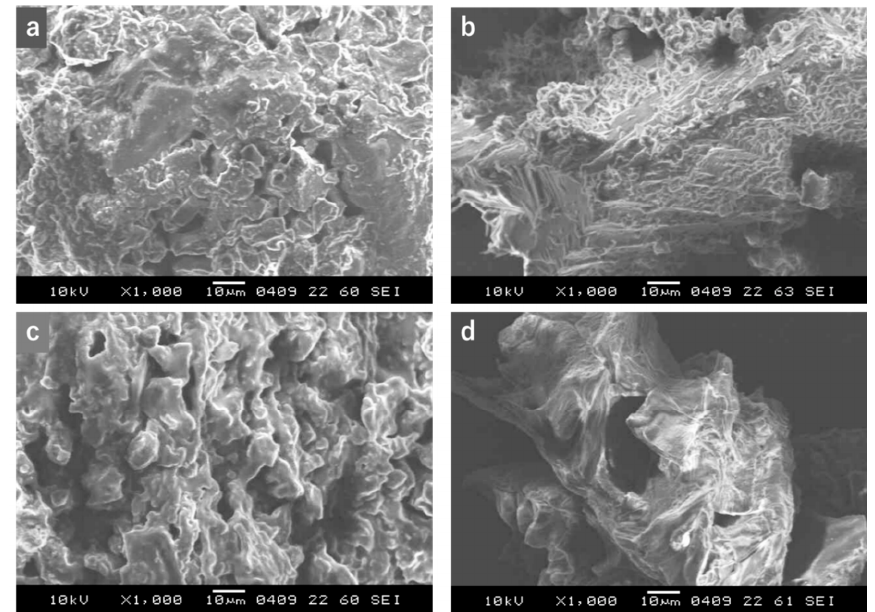
Figure 7. SEM 1000 images of ( a ) raw gardenia fruit pulp powder; ( b ) sample after SLE using 80% ethanol; ( c ) sample after CXE80% extraction; ( d ) sample after CXE80% extraction with direct sonication.